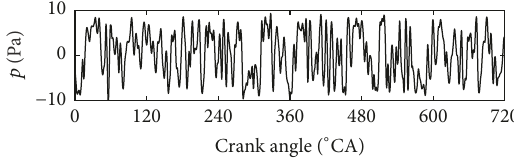
Figure 11: Preprocessed noise